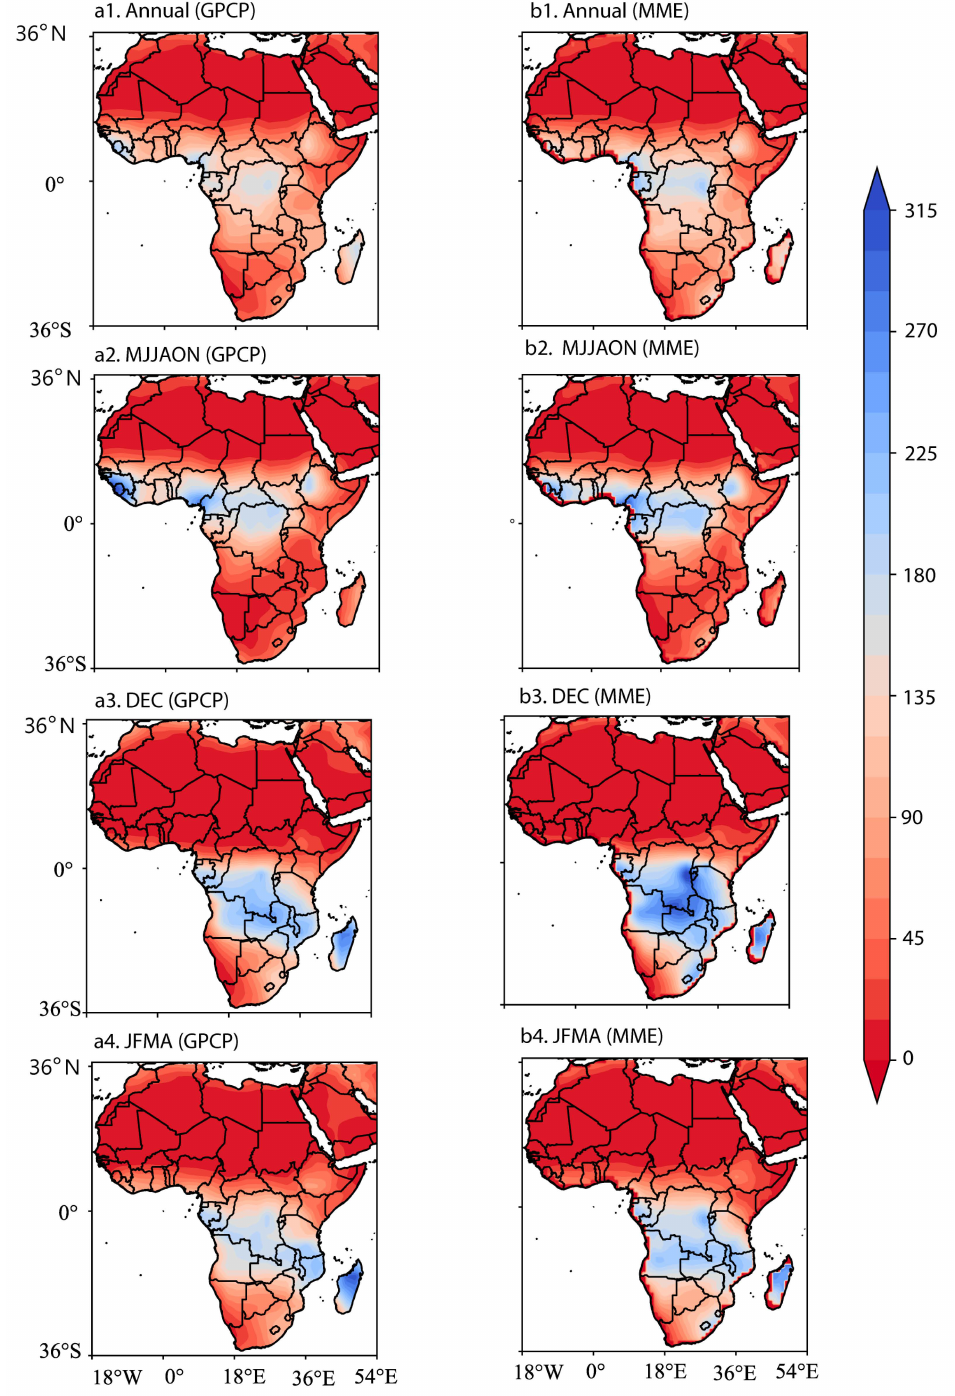
Figure 3. Spatial distribution of multi-year mean precipitation in GPCP ( a1 – a4 ), and MME ( b1 – b4 ) for annual ( a1 , b1 ), JFMA ( a2 , b2 ), MJJASON ( a3 , b3 ), and December ( a4 , b4 ) periods during 1980–2014. The unit is mm year − 1